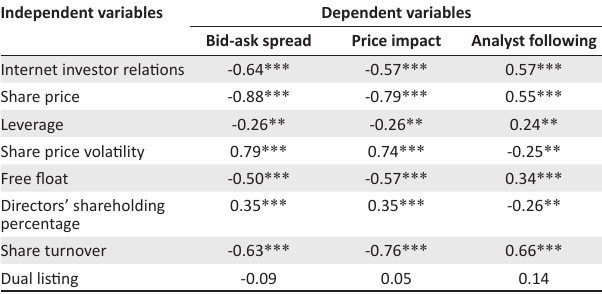
TABLE 4: Correlation matrix: Information asymmetry and independent variables. Independent variables